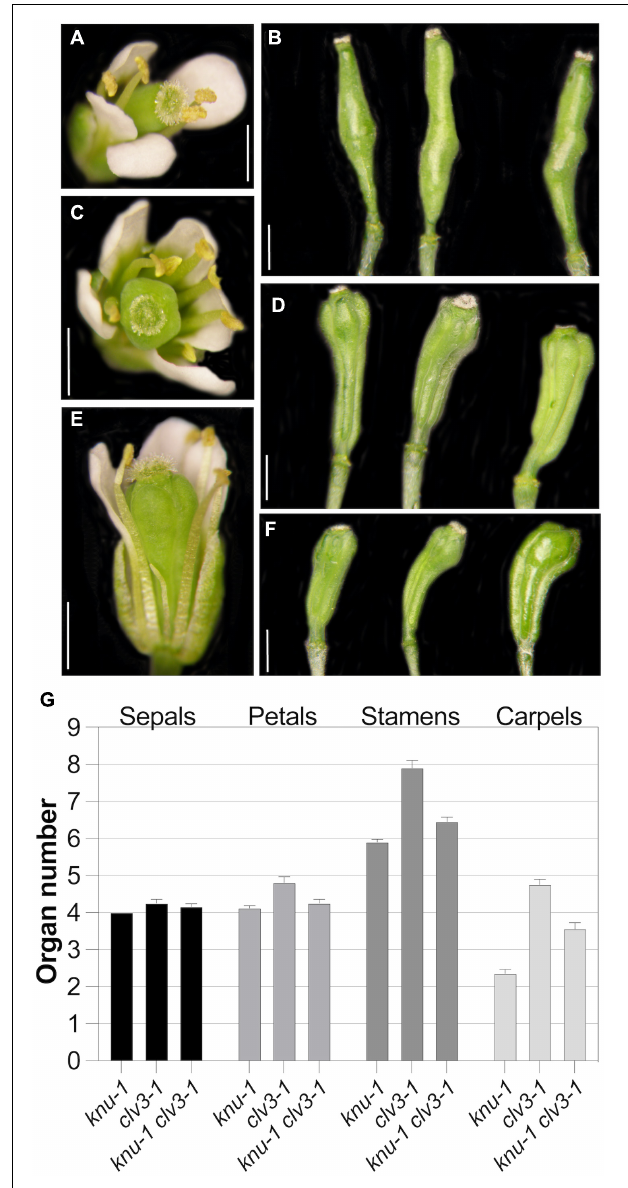
FIGURE 5 | Genetic interaction between knu-1 and clv3-1 . (A,B) Floral phenotypes of knu-1 in an L- er background. A flower (A) and bulged siliques (B) are shown. (C,D) Floral phenotypes of clv3-1 mutant plants. A flower with an increased number of floral organs (C) and multicarpelled siliques (D) are shown. (E,F) Floral phenotypes of knu-1 clv3-1 double-mutant plants. A flower (E) and siliques (F) are shown. In (E) , a petal was removed for better visibility of internal organs. Siliques shown in (F) were shorter than those of clv3-1 single mutants (D) . (G) Number of floral organs in knu-1 , c lv3-1